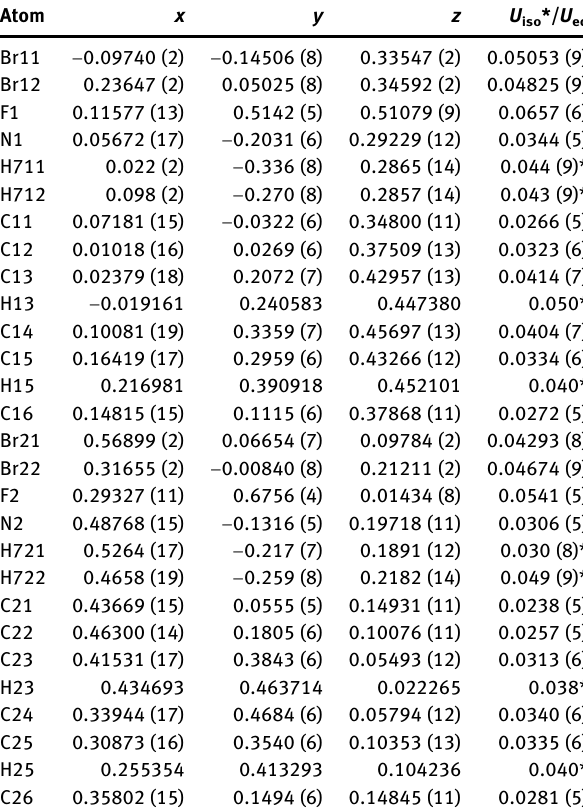
Table  : Fractional atomic coordinates and isotropic or equivalent isotropic displacement parameters (Å  ).